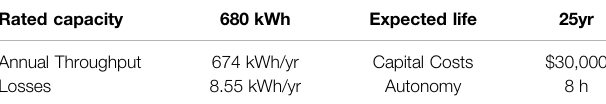
TABLE 9 | Battery energy storage system capacity and cost.